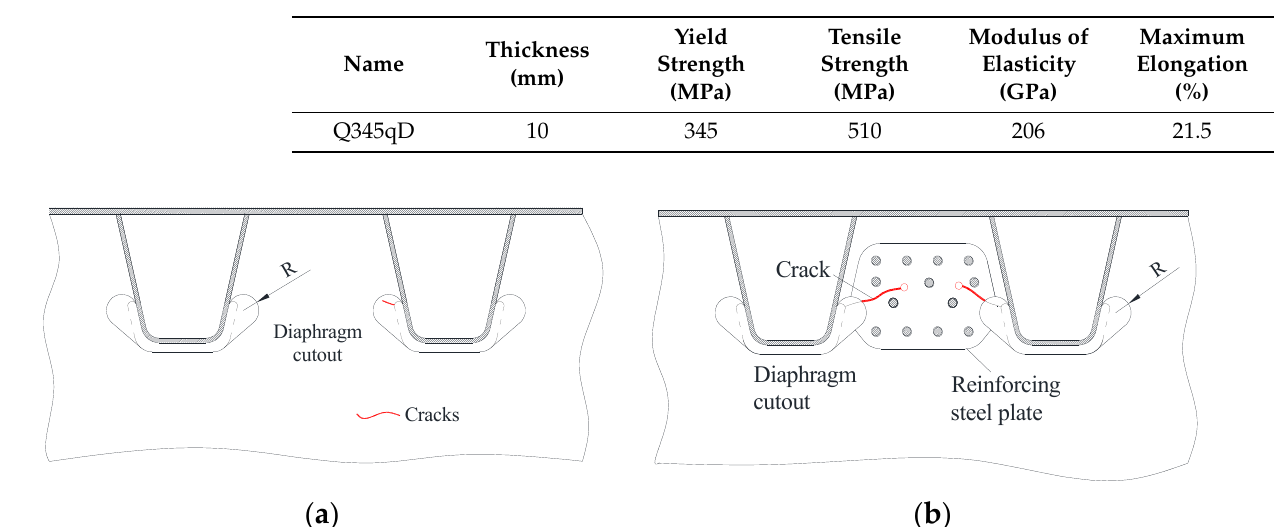
Figure 3. Schematic representation of the optimized reinforcement scheme for arc-shaped cuts: ( a ) Optimized plan when 0 < L1(L2) ≤ 25 mm, ( b ) reinforcement plan when L1(L2) > 25 mm.